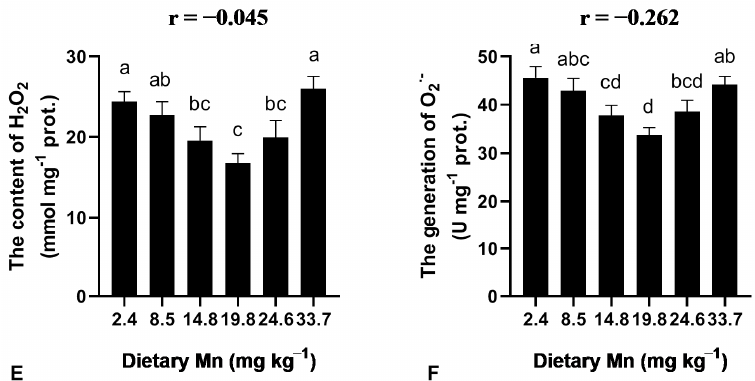
Figure 2. Effect of dietary Mn on the activities of antioxidant enzymes and ROS levels in the liver of post-larval coho salmon. ( A ) Mn-SOD activity; ( B ) CAT activity; ( C ) GSH-PX activity; ( D ) MDA content; ( E ) H 2 O 2 content; ( F ) Generation O 2 ·− . Data were expressed by mean ± SE ( n = 3). One-way ANOVA followed by Tukey HSD was used to determine whether Mn levels significantly ( p < 0.05) affected the observed responses. The different superscript letters are significantly different ( p < 0.05).